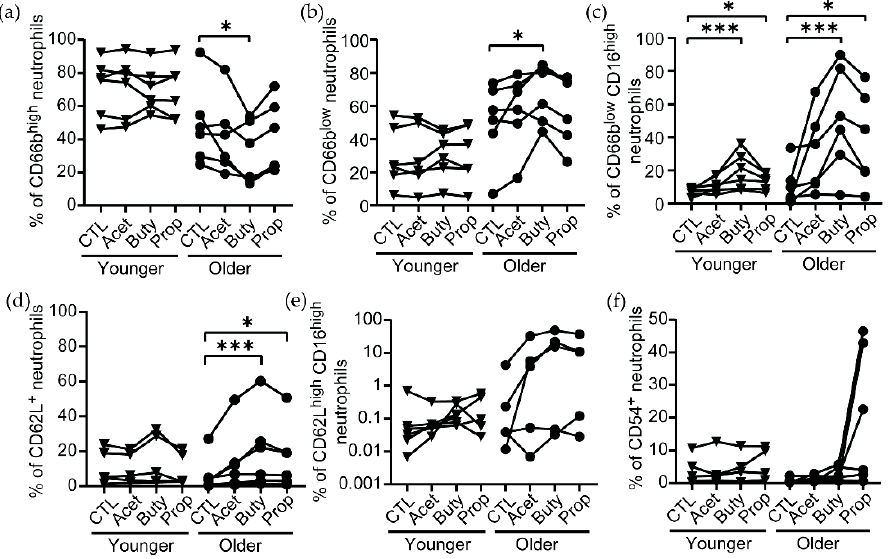
Figure 2. Pathological concentrations of butyrate and propionate preferentially modifies the pheno- type of neutrophils from older women. Effect of SCFAs on the percentage of ( a ) CD66b high , ( b ) CD66b low , ( c ) CD66b low CD16 high , ( d ) CD62L + , ( e ) CD62L high CD16 high , and ( f ) CD54 + neutrophils after 3 h of treatment (25 mM) in neutrophils from younger (triangles) and older women (circles), quan- tified by flow cytometry. Each dot represents a different patient (younger = 6; older = 5–6). Non- parametric paired Friedmann test was used, followed by Dunn’s post-test for multiple comparisons; * p ≤ 0.05, *** p ≤ 0.001. CTL: control; Acet: acetate 25 mM; Buty: butyrate 25 mM; Prop: propionate 25 mM.